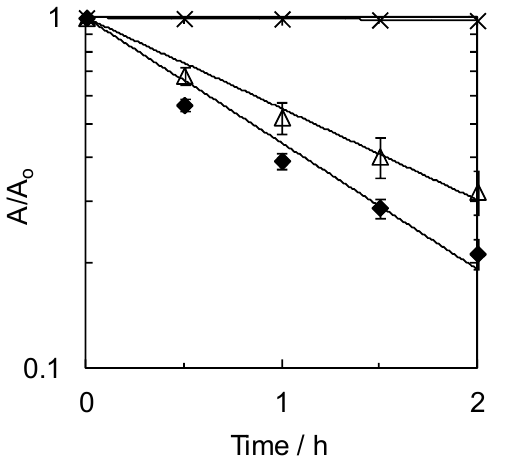
Figure 3. Methylene blue (MB) decolorization by the water-purification reactors. Crosses: blank; open triangles: BLB/TMiP reactor; solid diamonds: BLB/TMiP/air reactor. Reproduced with permission from Ochiai et al . [10], Catalysis Science and Technology; published by RSC Publishing,